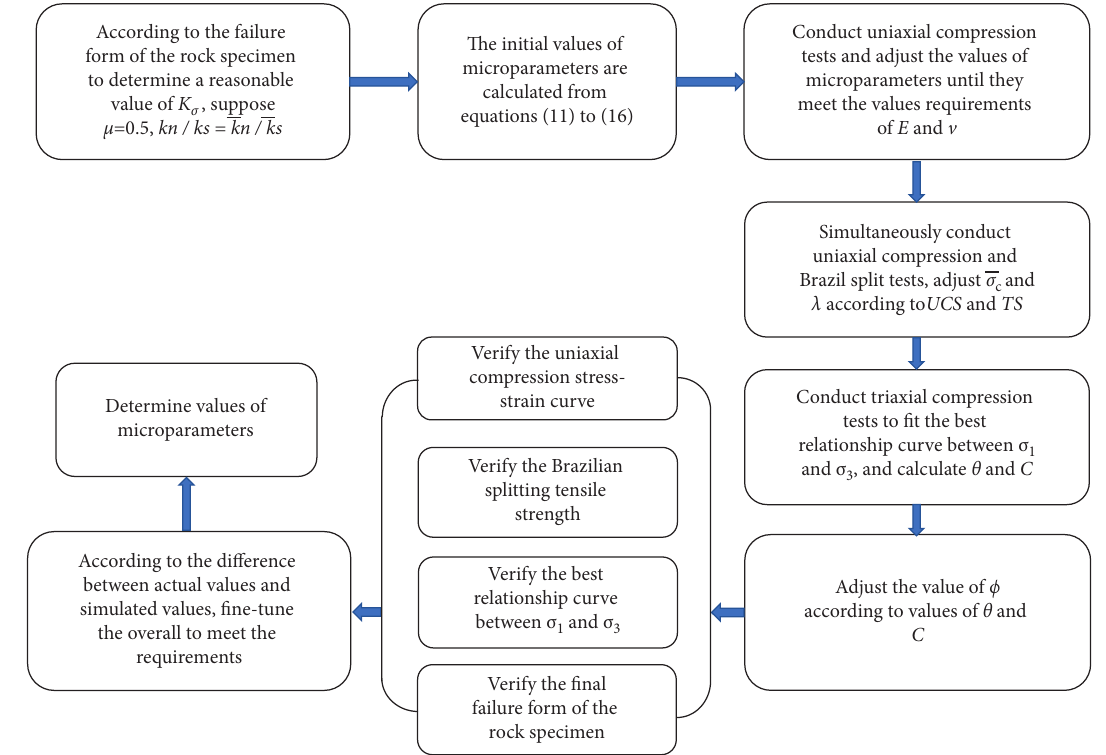
Figure 6: Flowchart of the calibration of